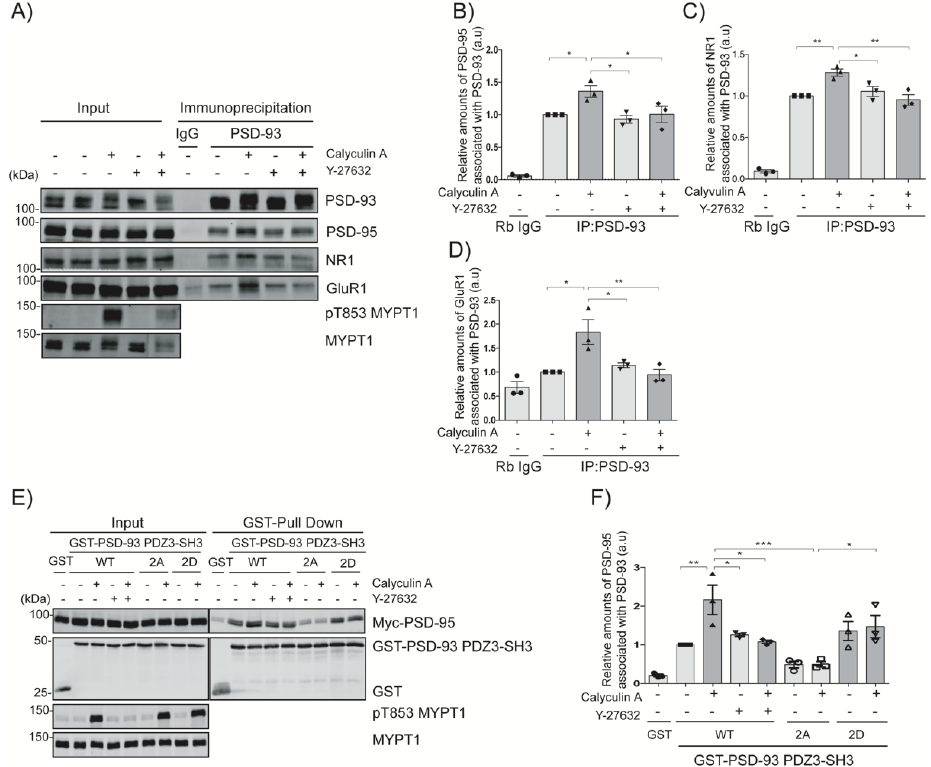
Figure 5. Rho-kinase positively regulates the interaction of PSD-93 with PSD-95, NMDARs and AMPARs. ( A ) PSD-93 phosphorylation by Rho-kinase increases its interaction with PSD-95, NR1 and GluR1 in striatal slices. Striatal slices were treated with calyculin A (250 nM) for 60 min after they were pretreated with Y-27632 (20 µM) for 60 min and then immunoprecipitated using an anti-PSD-93 antibody. The precipitated proteins were subjected to immunoblot analysis with antibodies against PSD-93, PSD-95, NR1, GluR1, pT853 MYPT1, and MYPT1 antibodies. ( B – D ) The bar diagram shows the statistical analysis results for the immunoblot data. The horizontal lines indicate the mean ± SEM of three independent experiments. * and ** represent p < 0.05 and p < 0.01, respectively, for Tukey’s multiple comparisons test. ( E ) Rho-kinase increased the interaction of PSD-93 with PSD-95 in COS7 cells: COS7 cells were cotransfected with Myc-PSD-95 and GST-PSD-93-PDZ3-SH3 (WT, phosphodeficient and phosphomimetic mutants) and then treated with calyculin A (50 nM) for 12 min with or without pretreatment with Y-27632 (20 µM). The samples were subjected to a GST pull-down assay. ( F ) The bar diagram shows the quantification of the immunoblot data. The horizontal lines indicate the mean ± SEM of three independent experiments. *, ** and *** represent p < 0.05, p < 0.01 and p < 0.001, respectively, for Tukey’s multiple comparisons test.